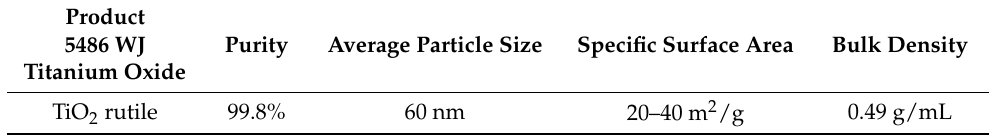
Table 3 . Data sheet from manufacturer (Nanostructured & Amorphous Materials Inc., Los Alamos, NM, USA).